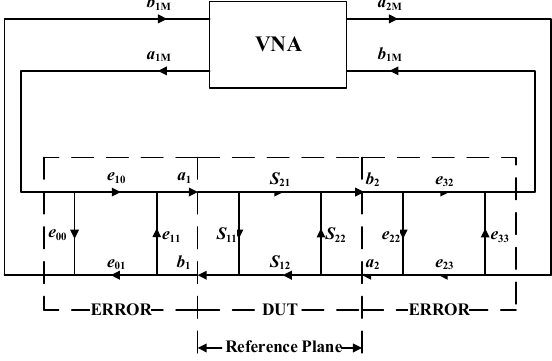
Figure 3. Schematic diagram of the 8 ‐ error ‐ terms model.